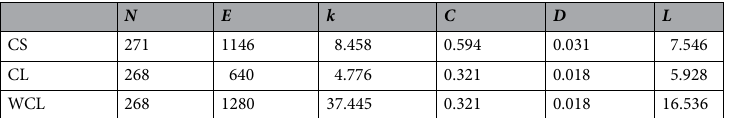
Table 1. Network metrics of the forested swamp plot. Indices in the table includes: N the number of nodes, E the number of edges, k the average node degree, D the density of the network, L the average path length. The value of C , D , L in WCL is identical to CL due to the same definition of network except for edge weight.